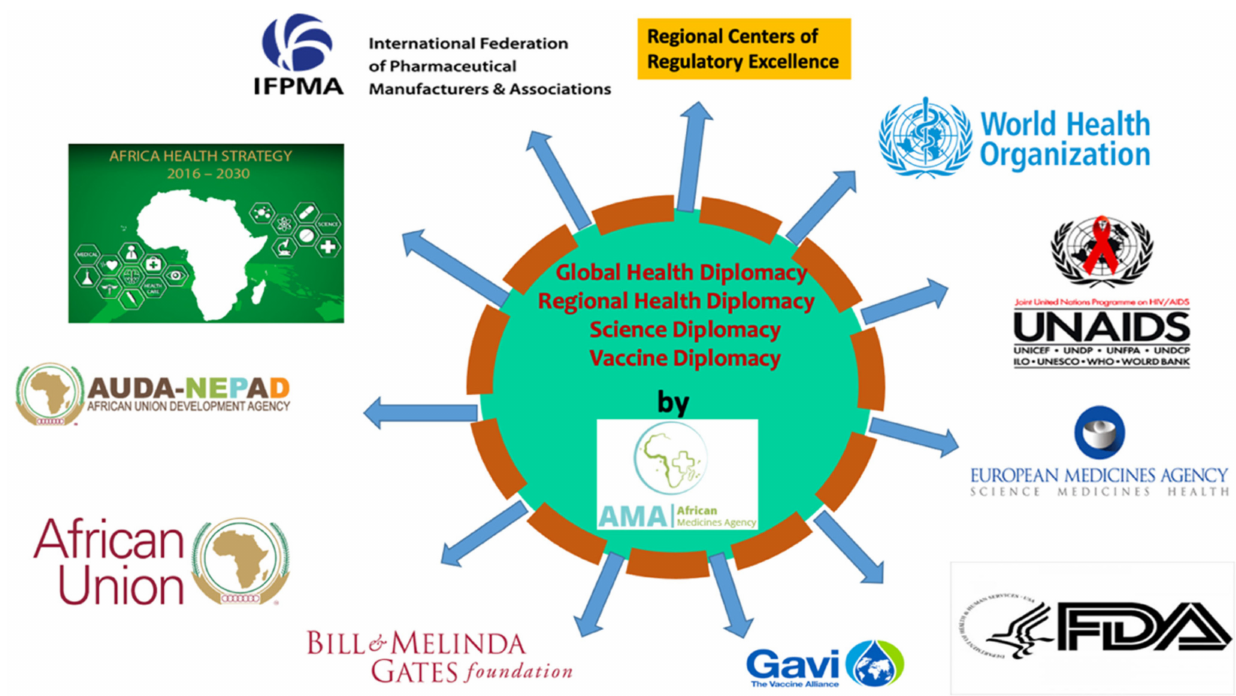
Figure 4. Engagement of African Medicines Agency in regional health/global health diplomacy with international partners. Source: conceptualized by the